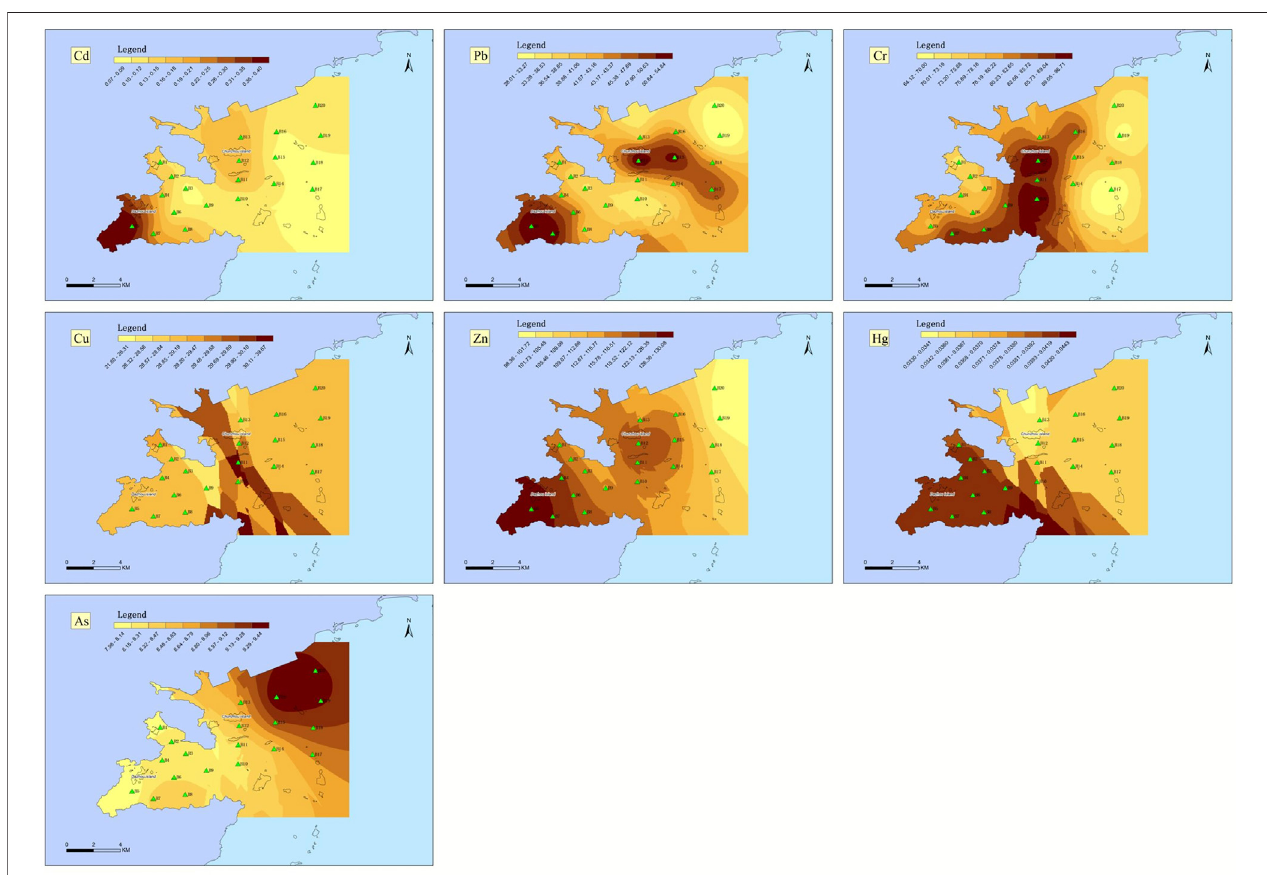
FIGURE 3 | Spatial distribution of heavy metals in surface sediments of the study area in spring.